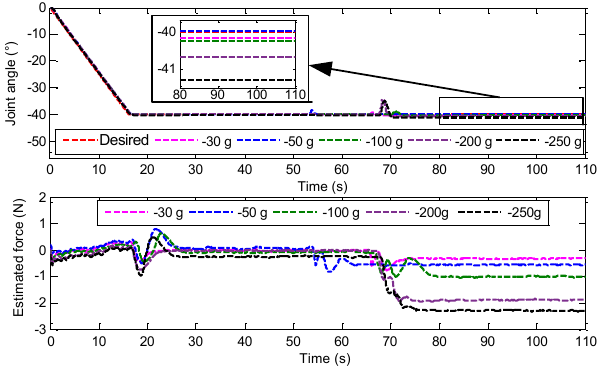
Figure 25. Positive direction loading experiment results at − 40 ◦